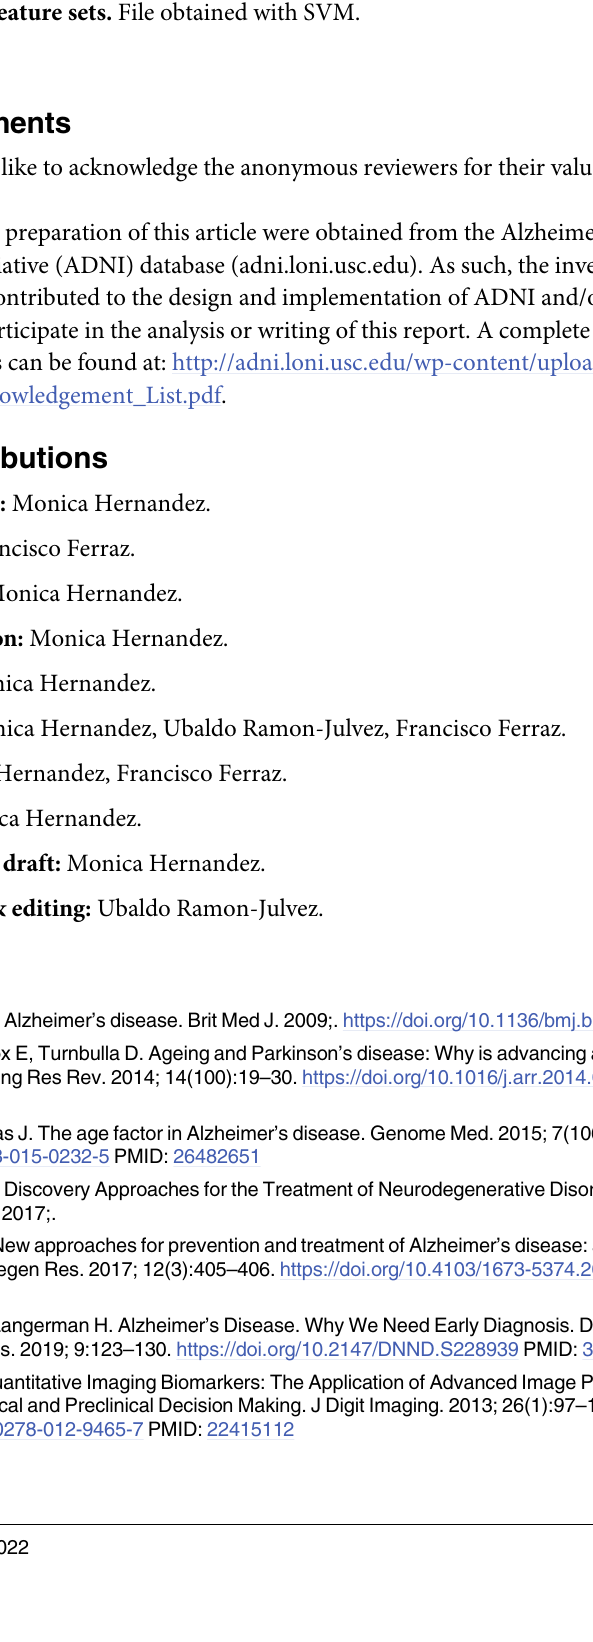
S2 Data. Frequency of the top 25 features over 10 experiments for the 100% training set and the different feature sets. File obtained with RF. (CSV) S3 Data. Frequency of the top 25 features over 10 experiments for the 100% training set and the different feature sets. File obtained with